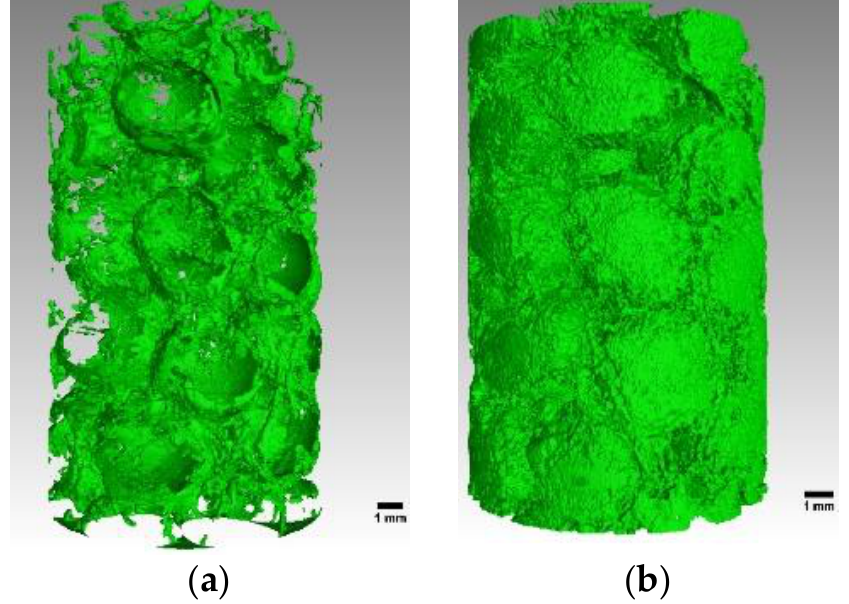
Figure 3. X-ray tomography images for biofilm structures in pore space with two types of contrast agents ( a ) barium sulfate and ( b ) iron sulfate. The obtained volumetric fraction of biofilms (green area) is much smaller by using barium sulfate as a contrast agent due to the long injection time.